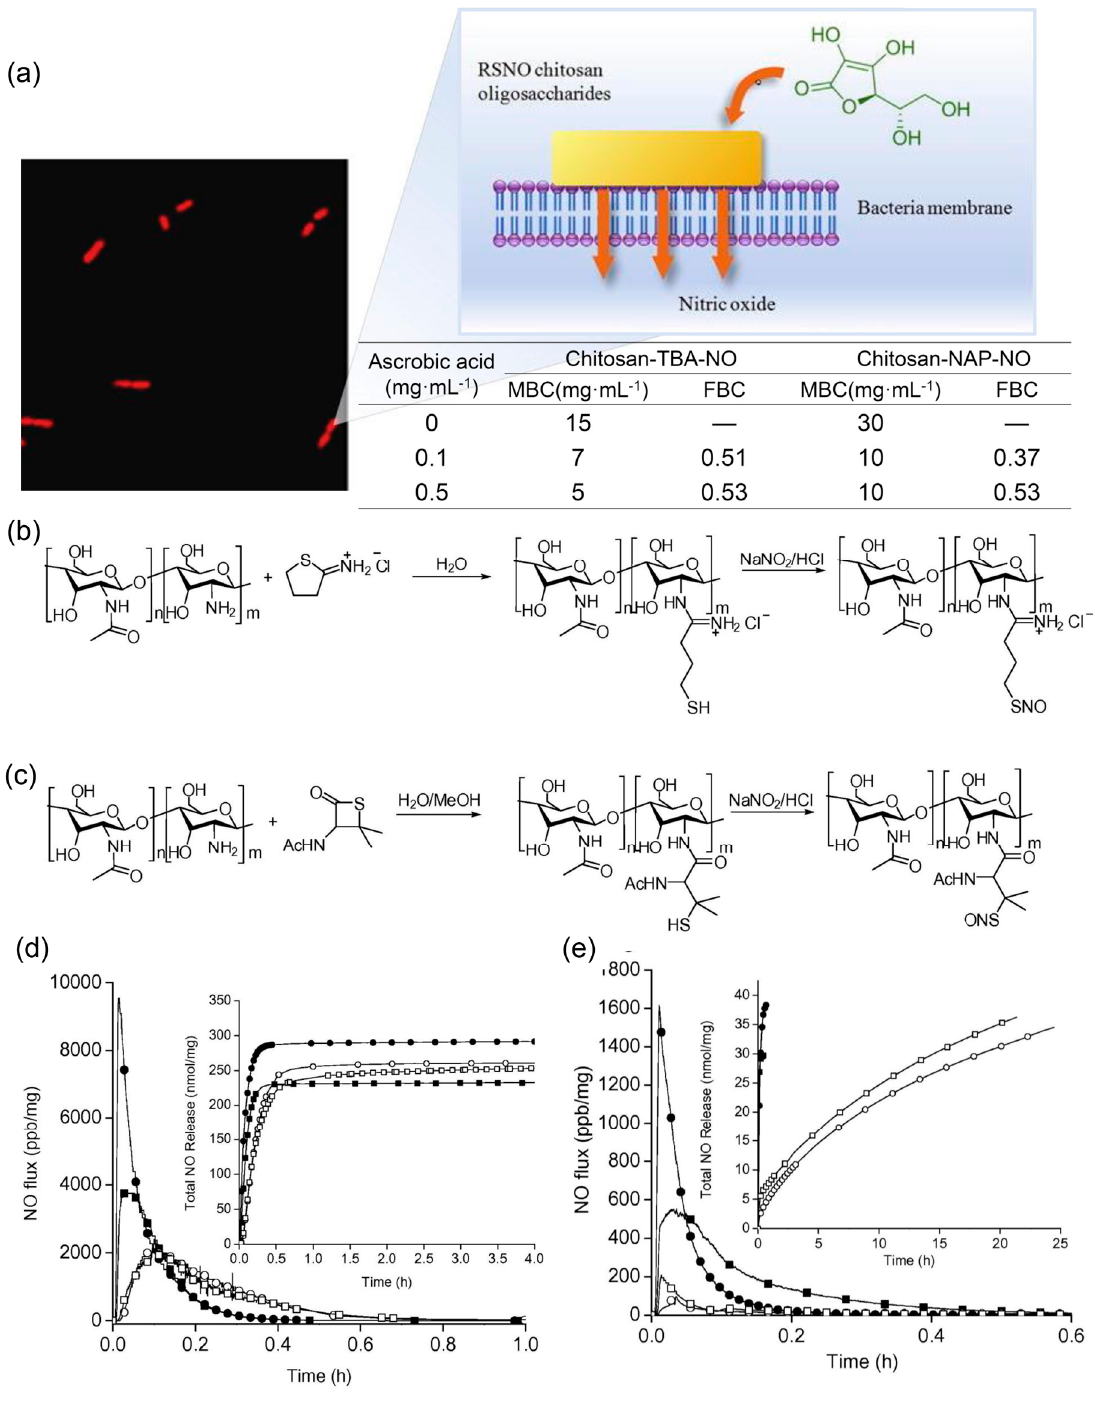
Figure 6. Synthesis of two S -nitrosothiol-modified chitosan oligosaccharides: chitosan-NAP-NO and chitosan-TBA-NO, and their release of NO and antibacterial effect in ascorbic acid. ( a ) The antibacterial effect of chitosan-NAP-NO and chitosan-TBA-NO respectively. ( b ) Synthetic method of chitosan-TBA-NO. ( c ) Synthetic method of chitosan-NAP-NO. NO release properties for ( d ) chitosan-NAP-NO and ( e ) chitosan-TBA-NO in 0.1 (square) and 0.5 (circle) mg mL − 1 ascorbic acid with (open) and without (solid) DTPA. Inset: total NO release with time (nmol mg − 1 ). Reproduced with permission from [125]. Copyright 2015, Elsevier.